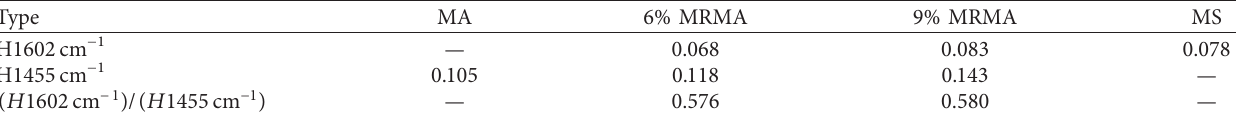
Table 4: Infrared absorption intensity at the wavenumbers 1602cm − 1 and 1455cm − 1 .